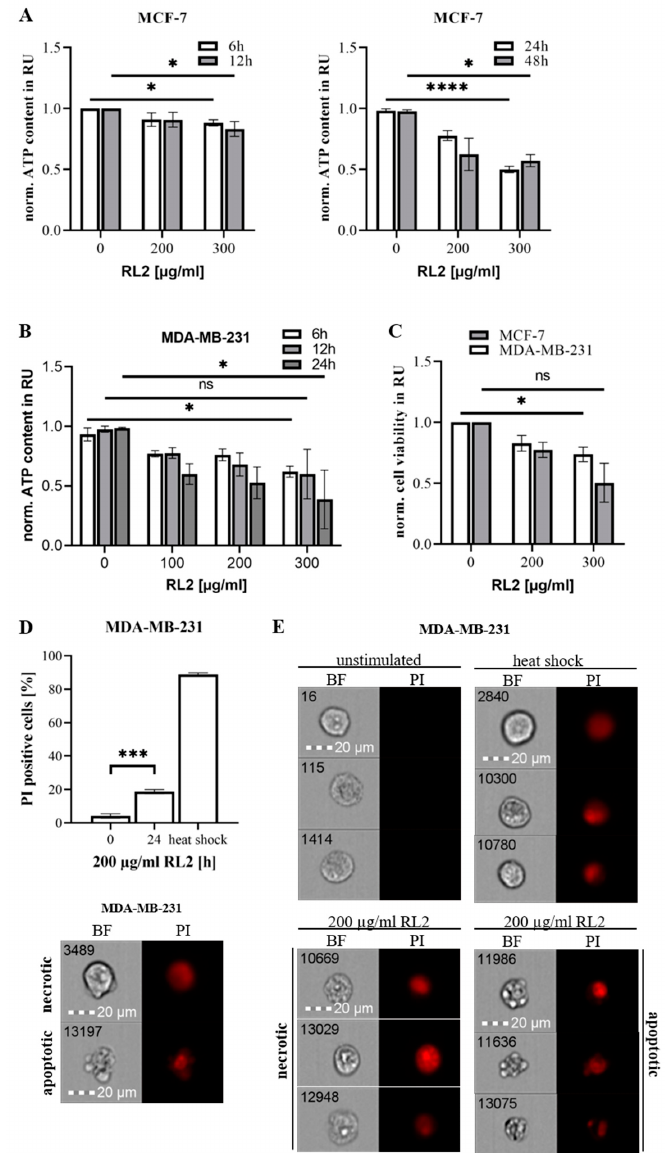
Figure 2. Treatment of RL2 promotes loss of ATP levels and cell death in breast cancer cells. ( A ) MCF-7 and ( B ) MDA-MB-231 cells were treated with indicated concentrations of RL2 for indicated time intervals. Cellular ATP levels were measured using the Cell Titer-Glo ® -Luminescent Cell Viability Assay. ATP levels are presented in relative units (RU) and normalized to the non-treated cells (norm.). ( C ) MCF-7 and MDA-MB-231 cells were treated with indicated concentrations of RL2 for 24 h. Cell viability was measured using the metabolic RealTime-Glo™ MT Cell Viability Assay. ( A – C ) Means and standard deviations are shown for three independent experiments. The statistical analysis was performed by one-way ANOVA test. ( D,E ) MDA-MB-231 cells were treated with 200 µ g / mL RL2 for 24 h. Cells were stained with PI and analyzed with FlowSight ® . ( D ) Top: The amount of PI positive cells from three independent experiments are shown in percentage. The statistical analysis was performed by paired student t-test. Bottom: The morphological features of apoptotic and necrotic cell death are shown exemplarily. Apoptotic cell can be characterized by membrane blebbing, cell shrinkage and nucleus fragmentation, whereas necrotic cell shows enlarged cell body and swollen nucleus. ( E ) Representative pictures of cells are shown. Heat shock treatment serves as positive necrosis control. ns (not significant; p > 0.05), * (significant; p < 0.05), *** (significant; p < 0.005), **** (significant; p <